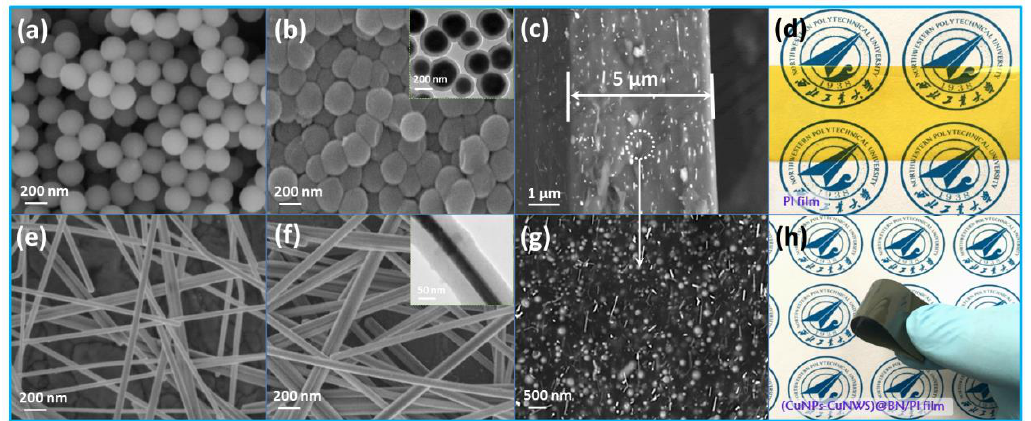
Figure 2. SEM micrographs of ( a ) CuNPs, ( b ) CuNPs@BN, ( c ) (CuNPs-CuNWs)@BN/PI film, ( e ) CuNWs, ( f ) CuNWs@BN, and ( g ) partial magnification of ( c ); TEM images of core-shell CuNPs@BN (inset of ( b ) and CuNWs@BN (inset of ( f ); optical micrographs of pure PI ( d ) and (CuNPs-CuNWs)@BN/PI ( h ) films.